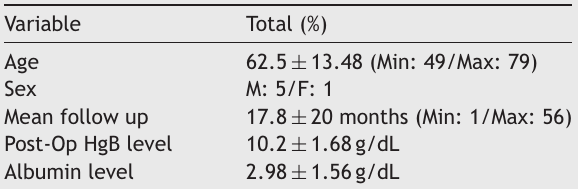
Demographic data of patients with larynx cancer and carotid